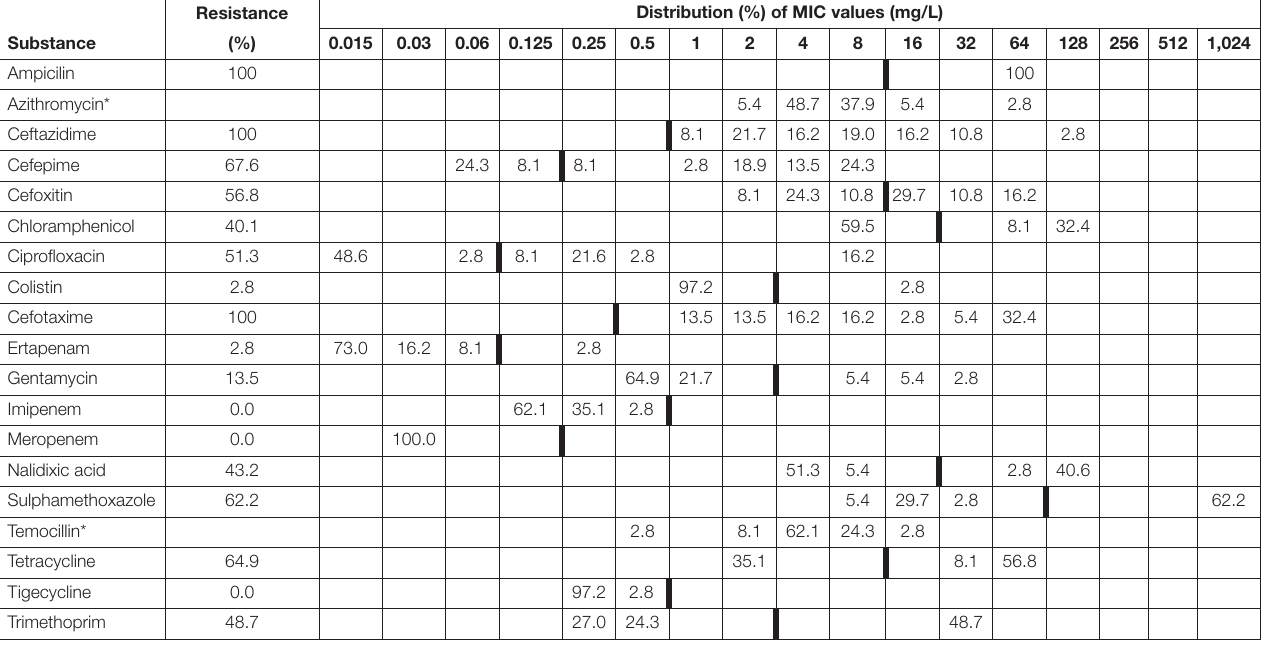
TABLE 3 | Minimum inhibitory concentrations (MICs) and antimicrobial resistance in ESBL/AmpC isolated from faecal samples ( n = 39) from red foxes ( Vulpes vulpes ) in Northern Ireland in 2018–2019.